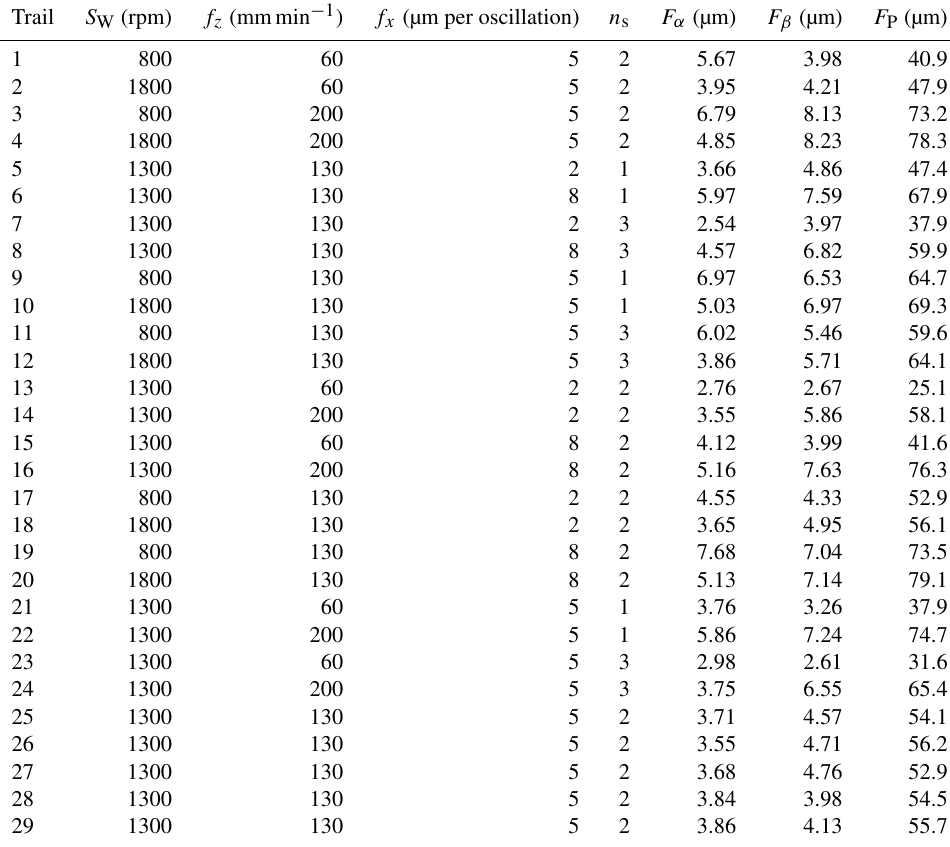
Table 4. IGPH experiments and measurement results based on the Box–Behnken DOE method.